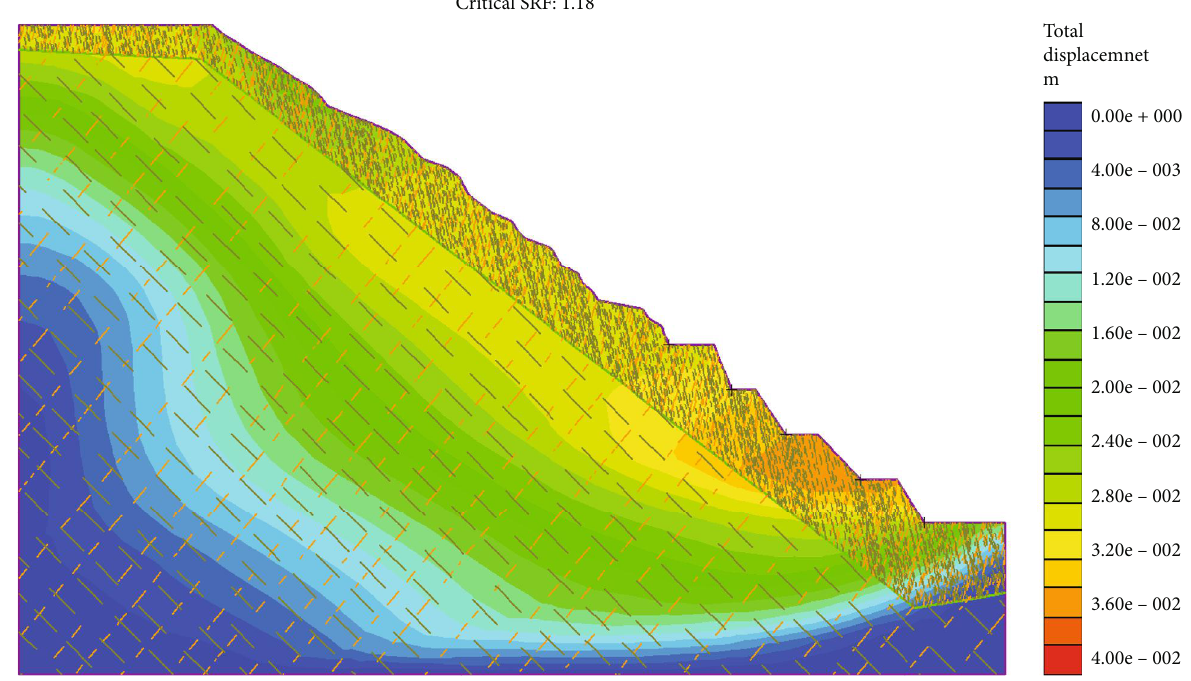
Figure 15: Cloud chart of total displacement for di ff erent times of the freeze-thaw